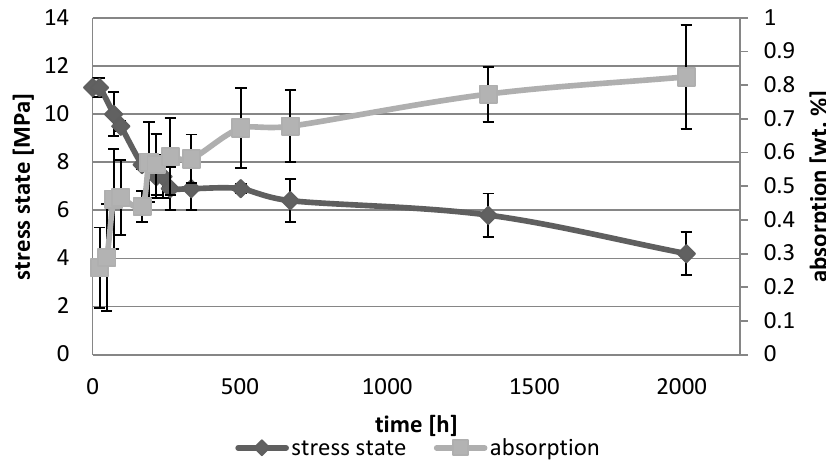
Figure 1. The relationship of absorption and stress state during water ageing (2016 h) of Beautifil Bulk Flow.